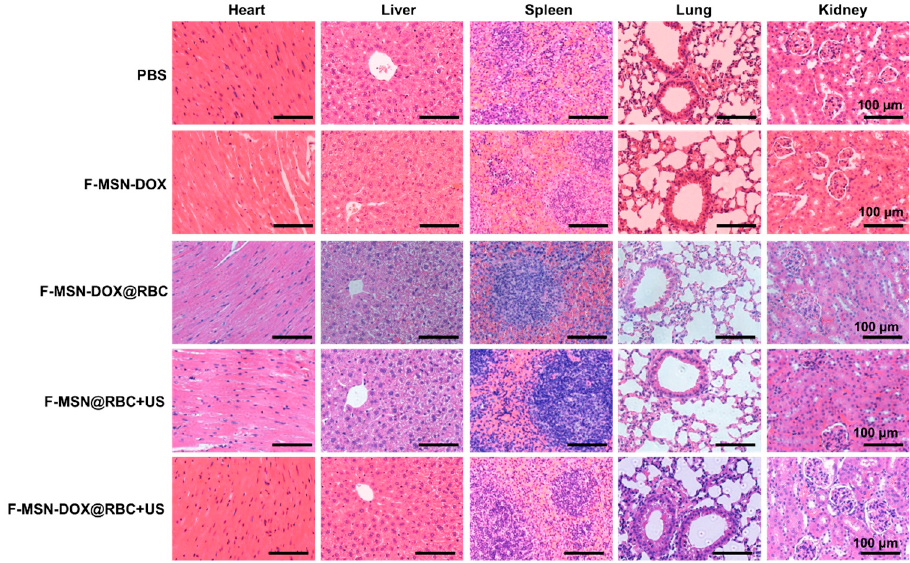
Figure 9. The HE staining histological images of the major organs under different treatments. The scale bar is 100 µm.